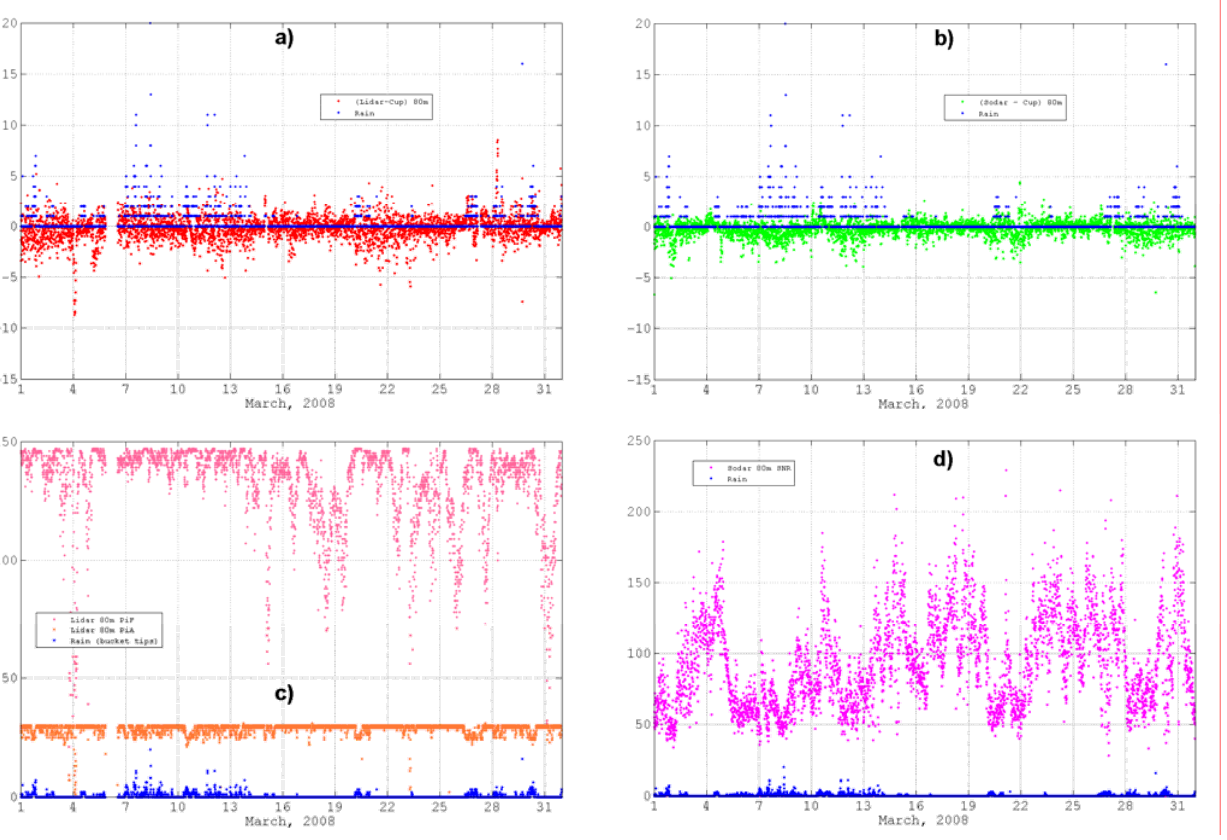
Figure 8. (a) LIDAR-Cup and (b) SODAR-Cup wind speed differences and rain; and internal quality parameters and rain: (c) LIDAR (PiF and PiA) and (d) SODAR (SNR). (Unfiltered; March data only; 10 min